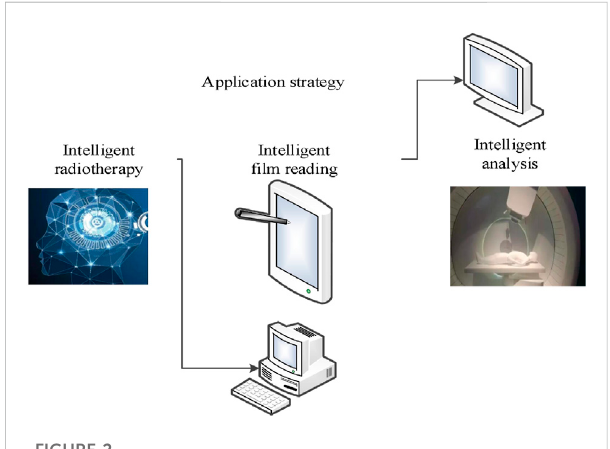
FIGURE 2 Application strategy of AI in medical imaging